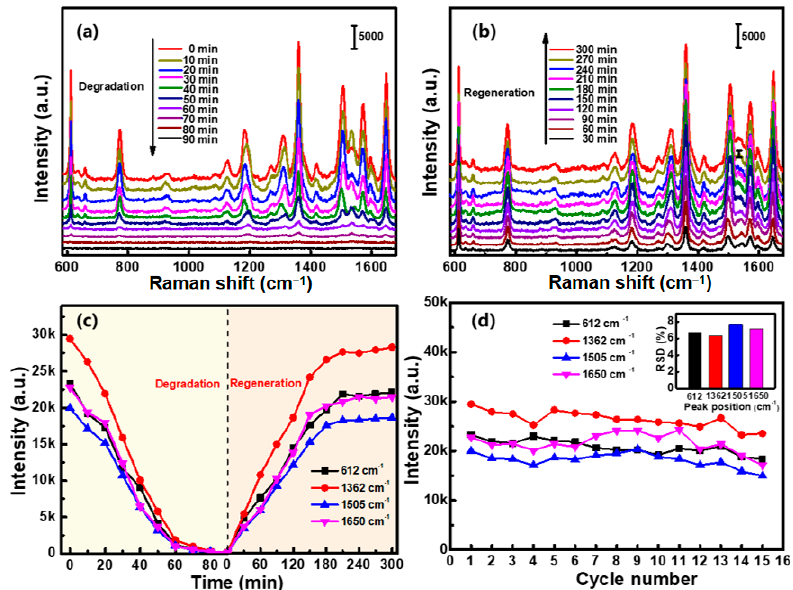
Figure 12. The recyclability of the 3D hierarchical Au/CuS MFs substrate: ( a ) SERS spectra acquired from the substrate irradiated by the simulated sunlight with different time durations. The substrate was initially soaked in 10 − 7 M R6G solution for 360 min. ( b ) Spectra of recyclable substrate by re-immersing in R6G solution with the same concentration. ( c ) The intensity variations of the four characteristic peaks of R6G molecule in degradation and regeneration process. ( d ) The intensity variations of R6G molecule acquired from the substrate at different reusage cycles. The inset is the finally obtained RSD